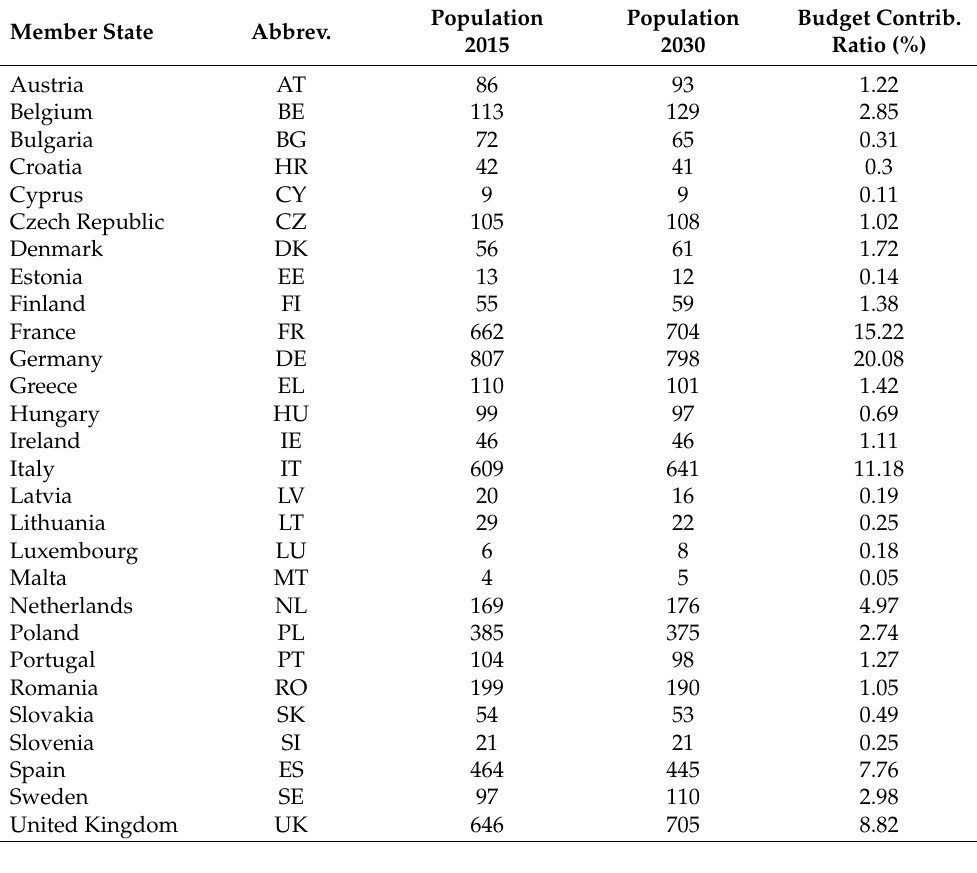
Table 4. Member states of the EU—population (in 100,000 s) and financial contribution.